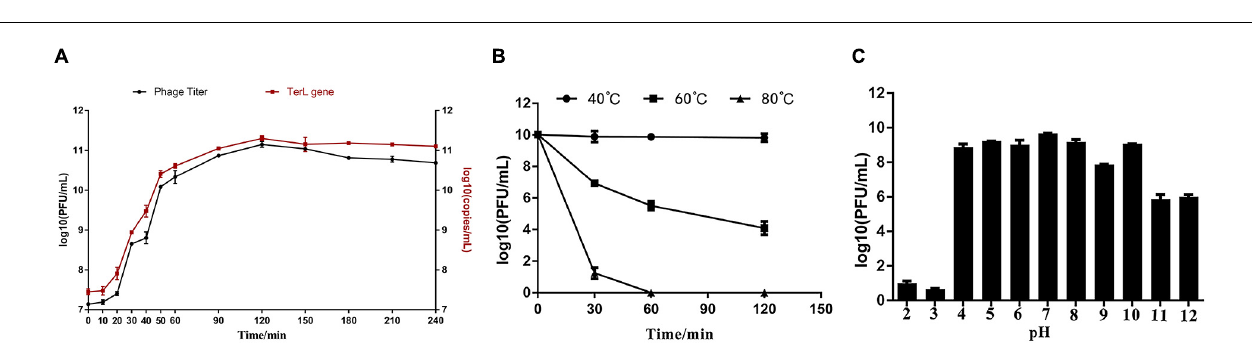
FIGURE 3 | (A) The one-step growth curve developed under the MOI of 0.001 showed that the latent period of Hafnia phage Ca was between 2 and 12 min, and its burst size was 10,292 ± 1,097 PFU/cell. (B) The influence of temperature on Hafnia phage Ca activity. The activity of phage Ca is stable at 40 ◦ C. The titer of